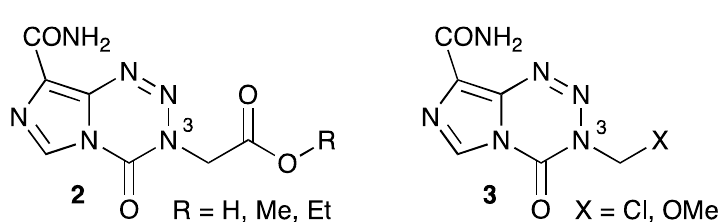
Figure 1. Novel TMZ-like